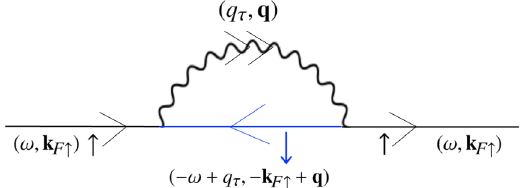
FIG. 10. Infrared finite one-loop contribution to the fermion self-energy. The internal (blue) fermion line is always evaluated off shell, that is, away from its Fermi surface. Note that in the different LOFF case, where the Cooperon carries finite momen- tum, this diagram can induce non-Fermi-liquid behavior. This case is further discussed in Sec.